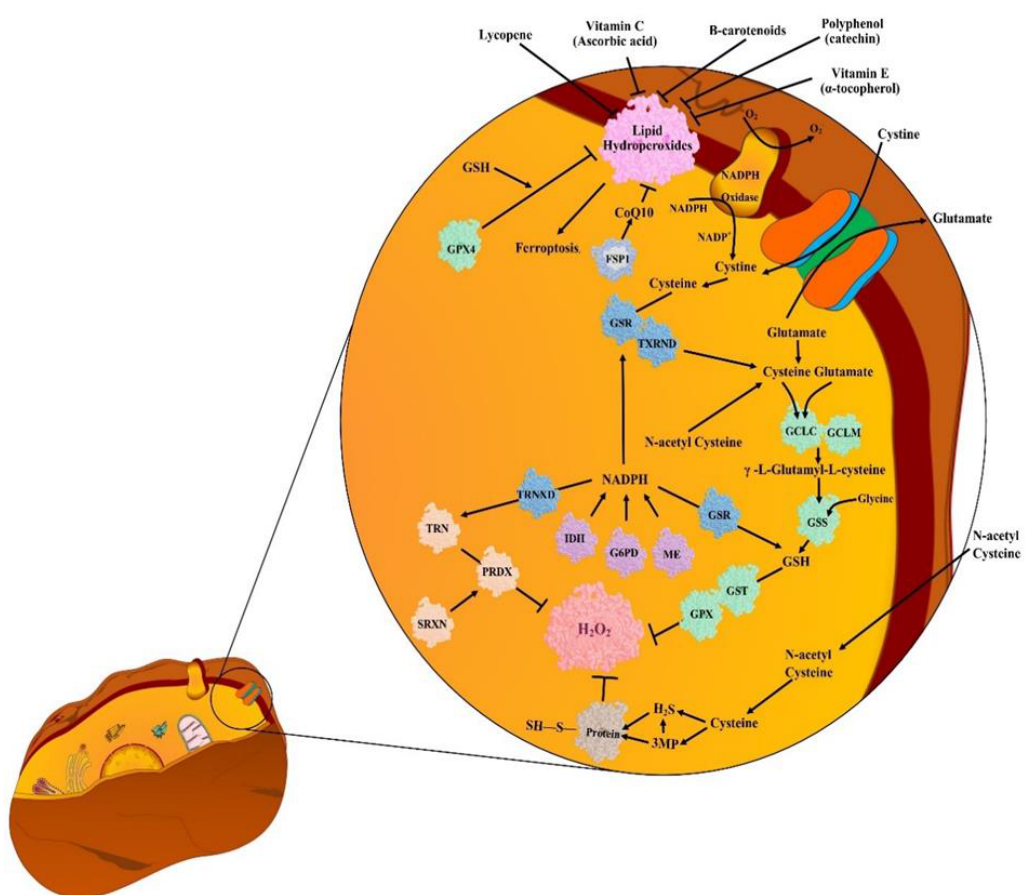
Figure 2. Various types of endogenous (EnAO) and exogenous (ExAO) antioxidants. NAC is reported to inhibit hypoxia inducible factor 1-alpha (Hif1a) stabilization and perturb the hepato-cellular xeno-graft tumor [157]. Despite preclinical data on NAC to aid clinical trials, no advantage was observed in the cancer patients. Several studies suggest that NAC promotes initiation, progression, and metastasis in mouse model of melanoma and lungs cancer [158,159]. Yet, the mechanics of NAC effect on cells redox status is unclear. As NAC contributes to synthesis of GSH synthesis, its AO function could be attributed to hydrogen sulfide formation and protein persulfidation [160]. Vitamin E (α -tocopherol) is recognized for its antitumor potential [161], but advent of beta-carotene to increase cancer incidence questioned the efficacy of vitamin E in cancer. Therefore, a multicenter clinical study was done over vitamin E to prevent prostate cancer, but study was stopped as vitamin E exhibited higher prostate cancer rate [162,163]. Evidence on one hand suggests that vitamin E promotes lung tumors and melanoma progression, and on the other hand it grows and directly prevents lipid oxidation and ferroptosis [164 – 166]. Generally, ExAO understanding becomes more complex when these molecules oxidize themself or produce ExAO independent effects. A recent study suggests that vitamin C (ascorbic acid) can autoxidize to dehydroascorbate (DHA) and may further increase the OS in cells [167]. Apart from that, vitamin C is also reported to negatively regulate the functioning of hematopoietic stem cell (HSC) by promoting ten-eleven translocation-2 (TET2) activity [168]; and NAC is reported to produce hydrogen sulfide (H 2 S) that may influence several metabolic and signaling pathways [169]. Hence, utmost